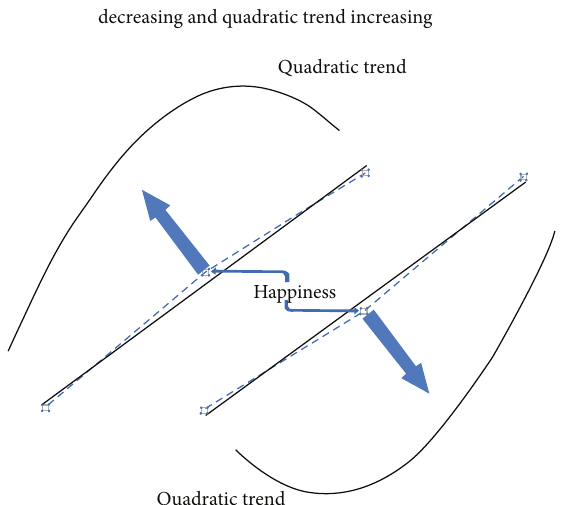
Figure 6: Dynamics of a happiness state, ceteris paribus . Here we illustrate linear or quadratic relationships among the three states regardless of Cartesian representation.